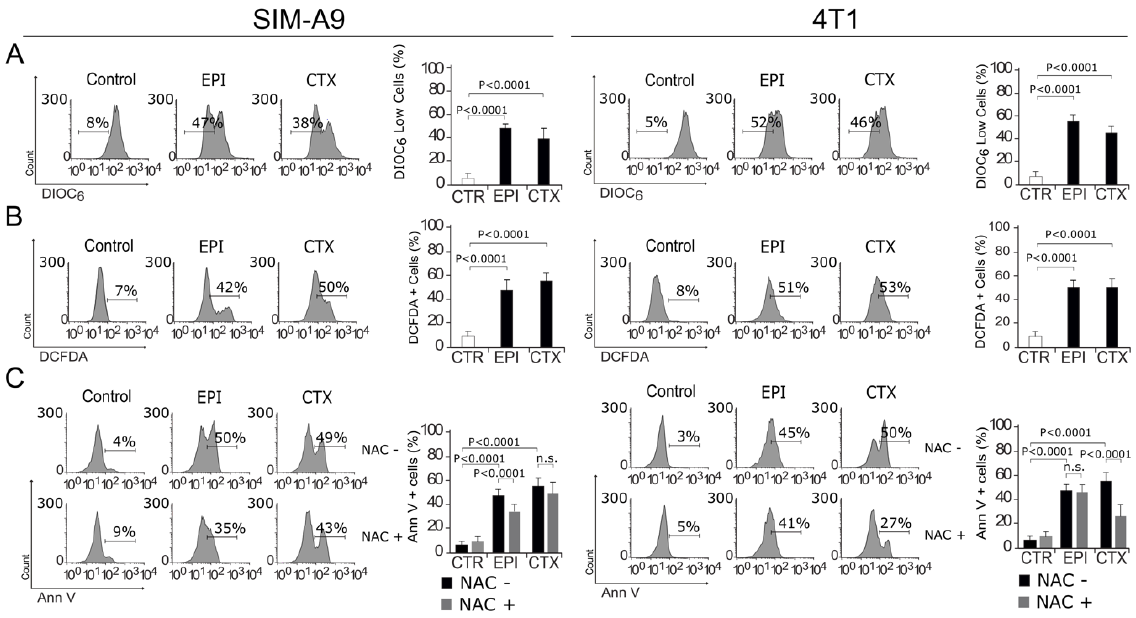
Figure 3: Mitochondrial alterations and ROS production. SIM-A9 and 4T1 cells were left without treatment (control) or treated with CC 50 of EPI and CTX for 24 h and assessed by flow cytometry. A ) Representative histogram of mitochondrial membrane potential measured by DIOC6 staining (left), bars represent the mean  SD (right). B) Representative histogram of ROS production measured with DCFDA (left), bars represent the mean  SD (right). C ) Representative histogram of Annexin V staining, in cells pre-treated or not with the antioxidant NAC and then treated with EPI or CTX (left), bars represent the mean  SD